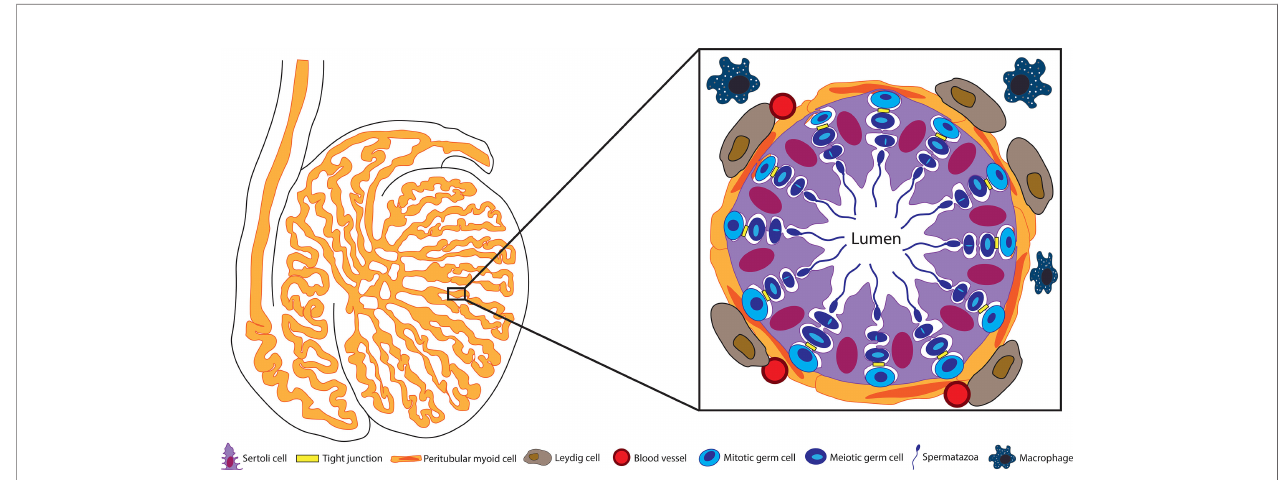
FIGURE 1 | Structure of the seminiferous tubule. Spermatogenesis takes place within the seminiferous tubules. These tubules are surrounded by peritubular myoid cells and contain the germ cells engulfed by Sertoli cells. The BTB between adjacent Sertoli cells separates the seminiferous epithelium into the basal and adluminal compartments. Blood vessels, Leydig cells, and testicular macrophages are located outside the tubules in the testis